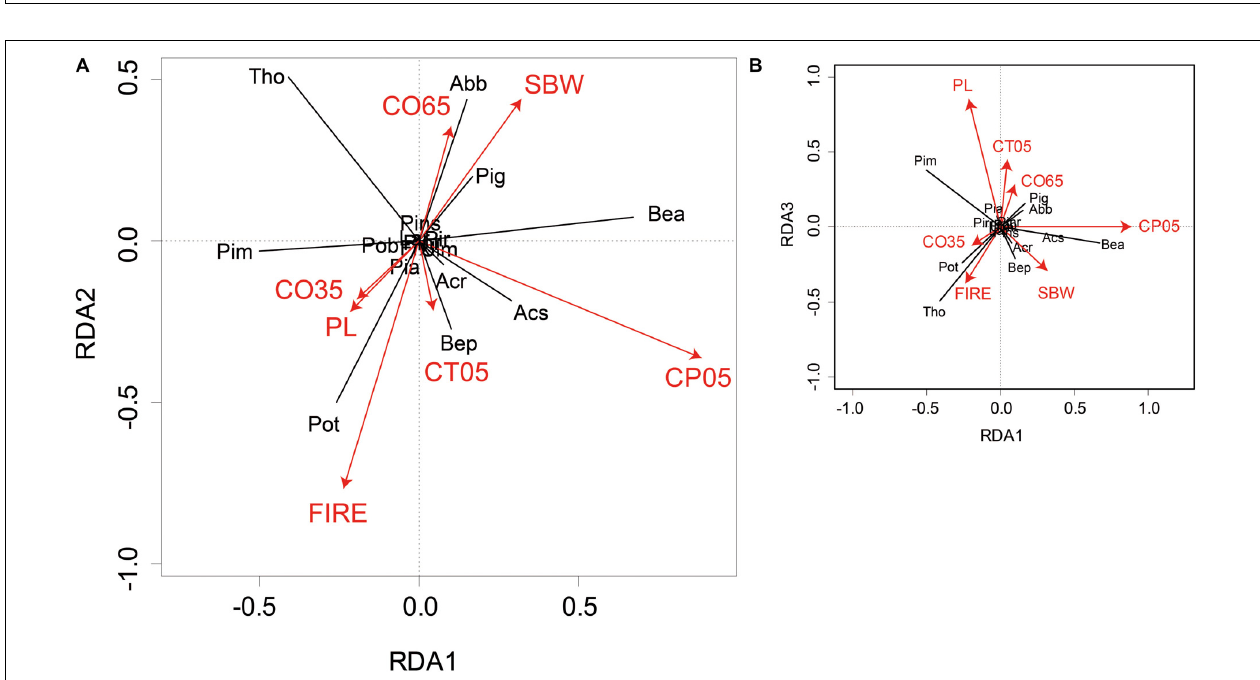
FIGURE 6 | Redundancy analysis (model Adjusted R2 = 6%) of taxa basal area in 2005 (black lines) correlated to 7 disturbance explanatory variables (red vectors). Projections showed using (A) first and second ordination axes and (B) first and third ordination axes. N = 4573 temporary plots of the 2nd, 3rd, and 4th government decennial inventories. Frx, Ash; Abb, Balsam fir; Tho, Northern white cedar; Ulm, American elm; Lar, American larch; Acr, Red maple; Acs, Sugar maple; Pob, Balsam poplar; Pot, Trembling aspen; Pins, White pine; Pinr, Red pine; Pim, Black spruce; Pia, Norway spruce; Pir, Red spruce; Pig, White spruce; Bea, Yellow birch; Bep, White birch. Acronyms of explanatory variables are indicated in the Table 5 .